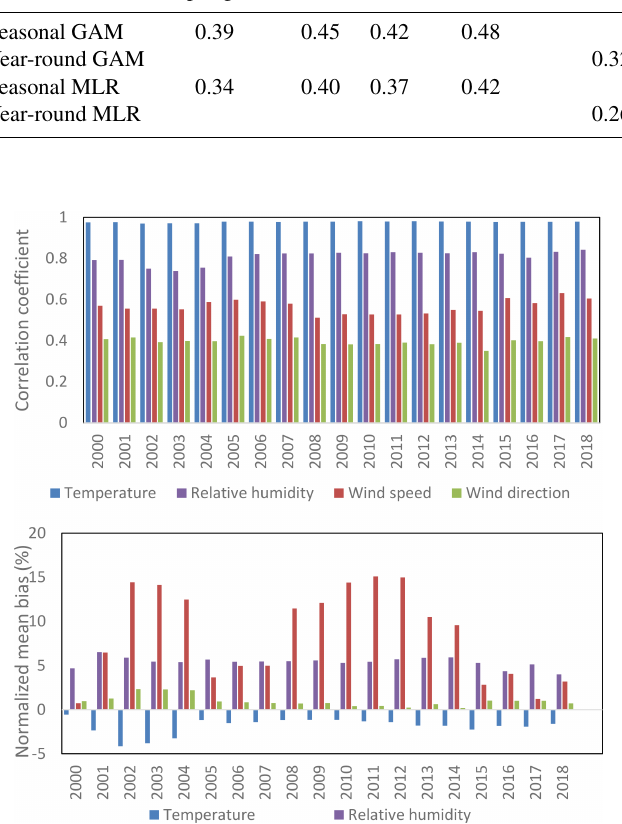
Figure A1. Evaluation of the WRF model simulations. The correlation coefficient and normalized mean bias were calculated by comparing WRF simulations with ground observations from the National Climate Data Center.